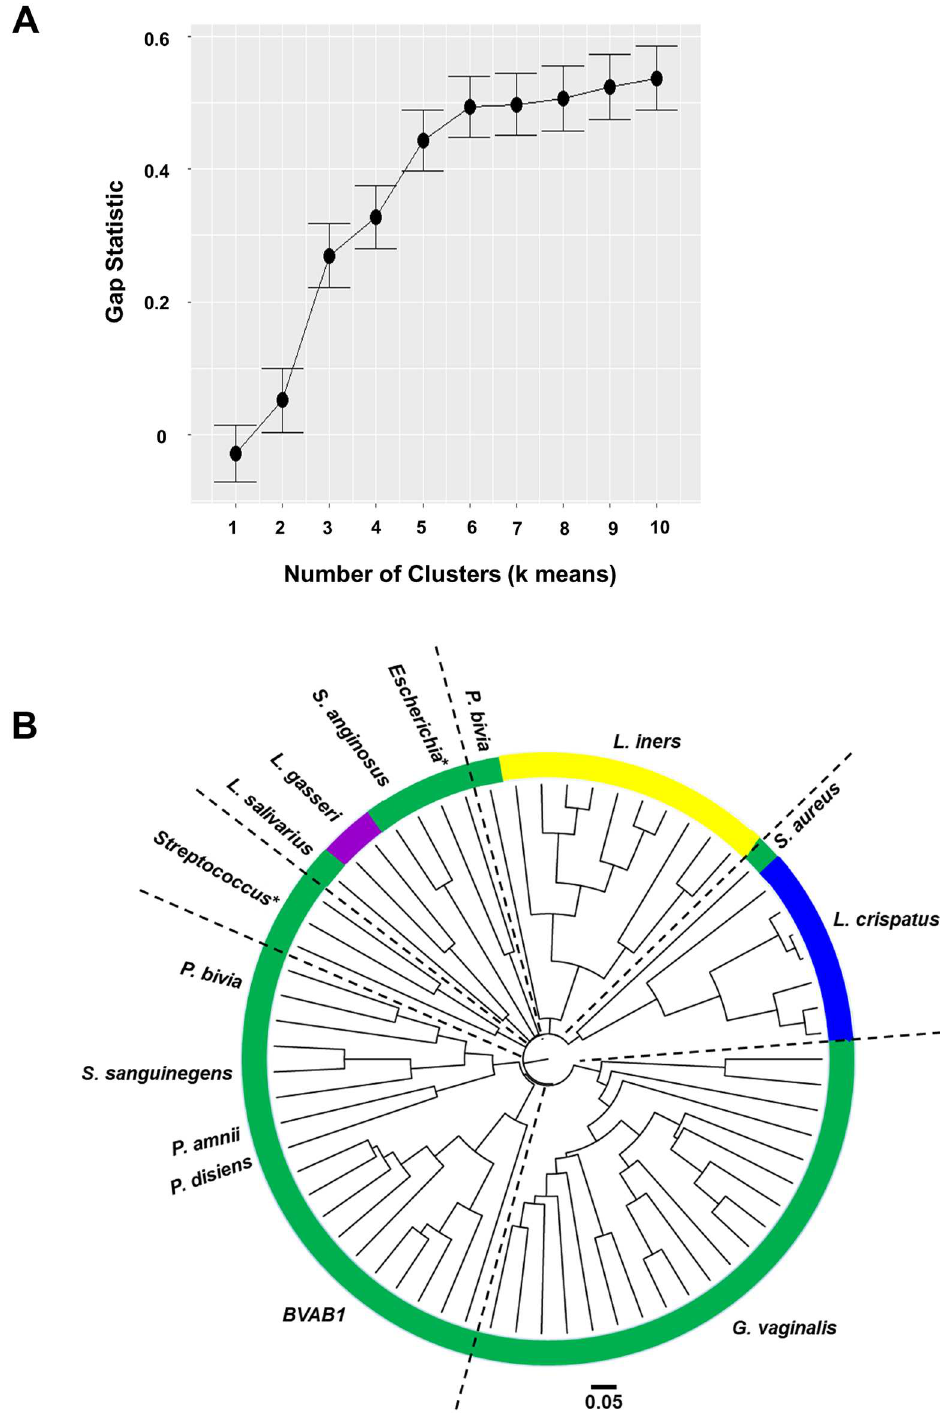
Fig 5. Six distinct vaginal microbiota clusters are found within this group of women. The gap statistic, which gives an estimationof how well ‘k’ (number of clusters) fits the data, was calculated(A). The number of clusters present in the data is indicatedby the plateauin the gap statistic, which occurred at 6. A cluster dendrogram was created in order to better visualizethe clusters (B). Three sub-clusters within community state type (CST) IV (green, high diversity) were identified.One sub-cluster had Streptococcus as the dominant genus, another had G . vaginalis ,while the third had Prevotella/Sneathia/BVAB1 and was more